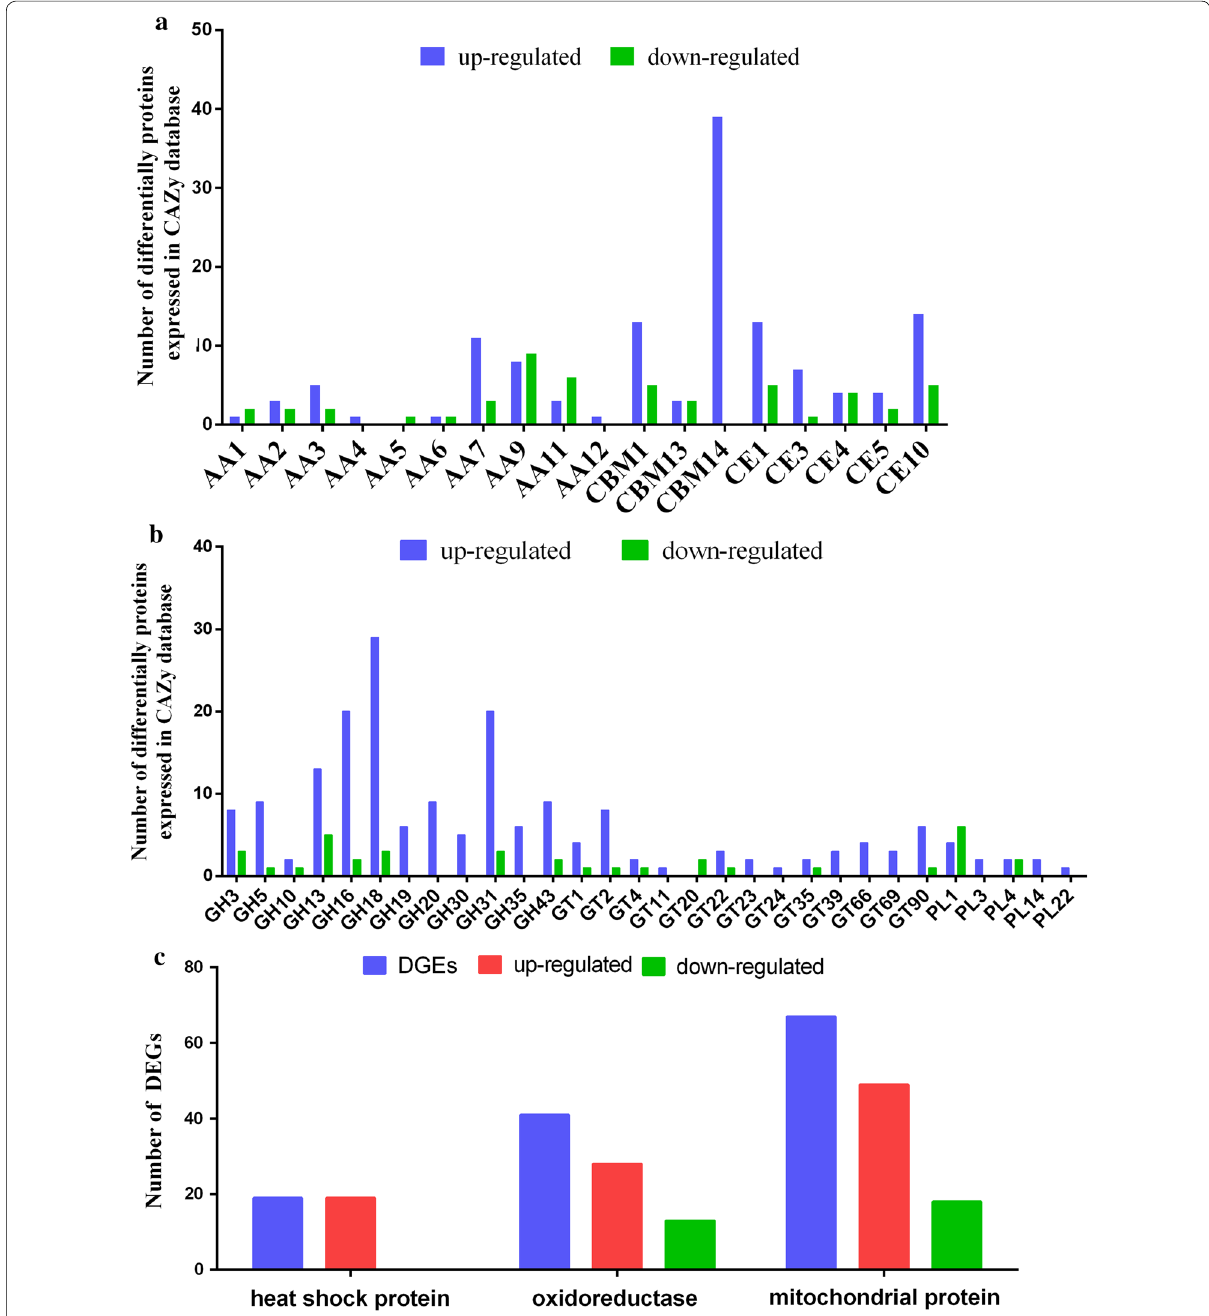
Fig. 2 Histogram showing differentially expressed CAZyme, mitochondrial protein, oxidoreductase and heat shock protein genes. a , b The number of differentially expressed proteins in the CAZy database. The blue areas represent upregulated expression, and the green areas represent downregulated expression. c The number of mitochondrial, oxidoreductase and heat shock protein DEGs; the blue areas represent the total DEG number, the red areas represent genes with upregulated expression, and the green areas represent genes with downregulated